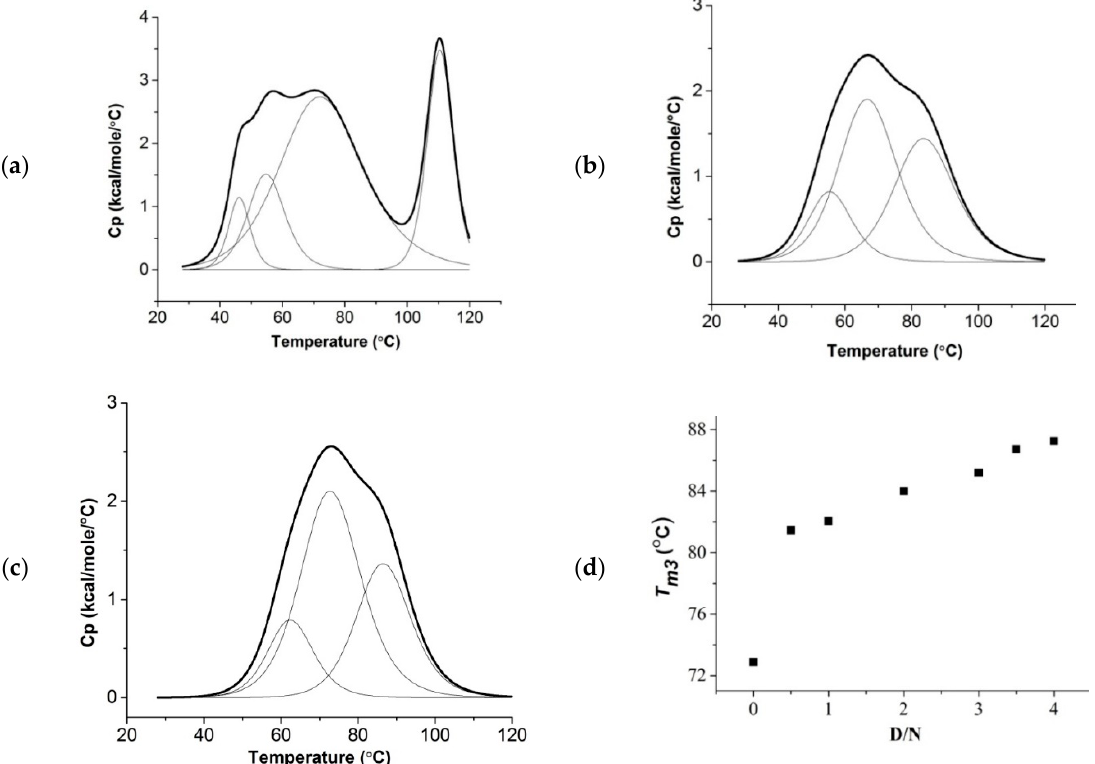
Figure 9. Differential scanning calorimetry (DSC) thermograms showing excess heat capacity as a function of temperature; ( a ) 50 μ M of free [d-(TTGGGGT)] 4 ; daunomycin-[d-(TTGGGGT)] 4 complex at ( b ) D/N = 2.0 and ( c ) D/N = 3.5. All samples were prepared in phosphate buffer (KBPES) (pH 7.0) containing 100 mM of KCl. ( d ) The plot of melting temperature T m3 obtained from DSC experiments as a function of D/N ratio.